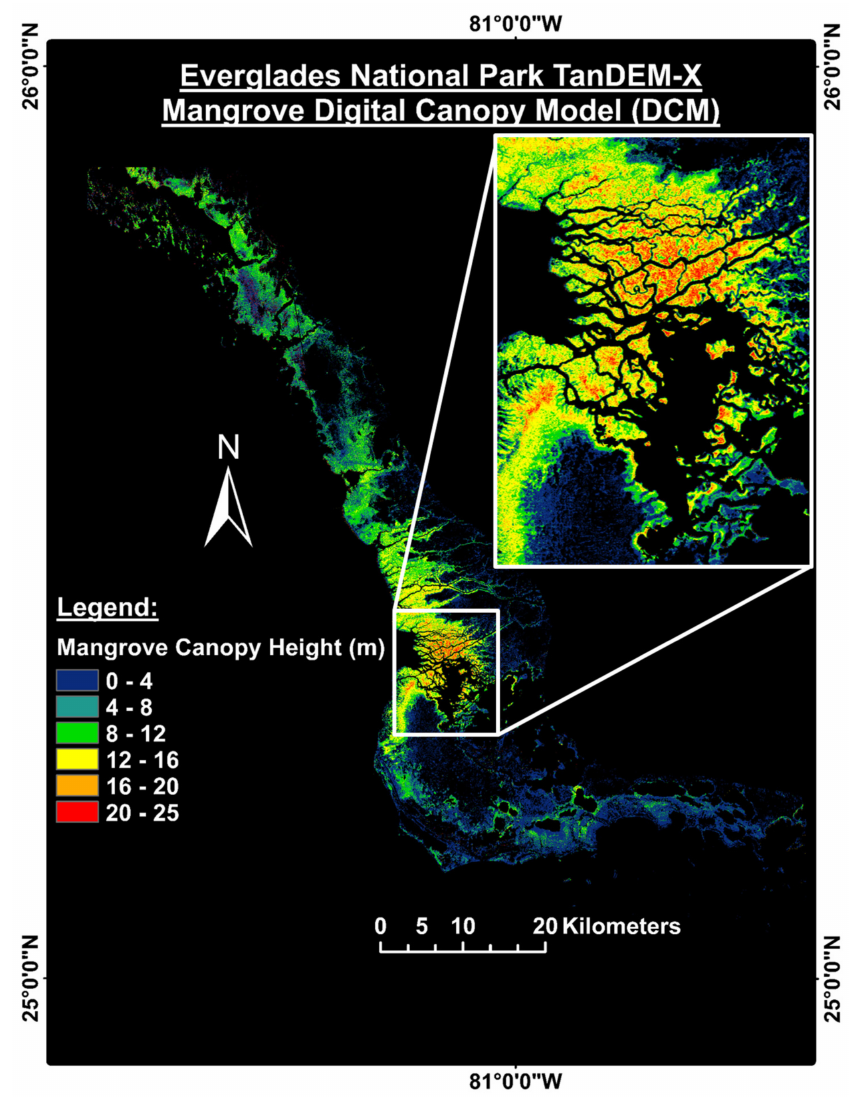
Figure 8. Everglades National Park 12-m resolution TDX-based mangrove DCM with a zoomed area in the SRS